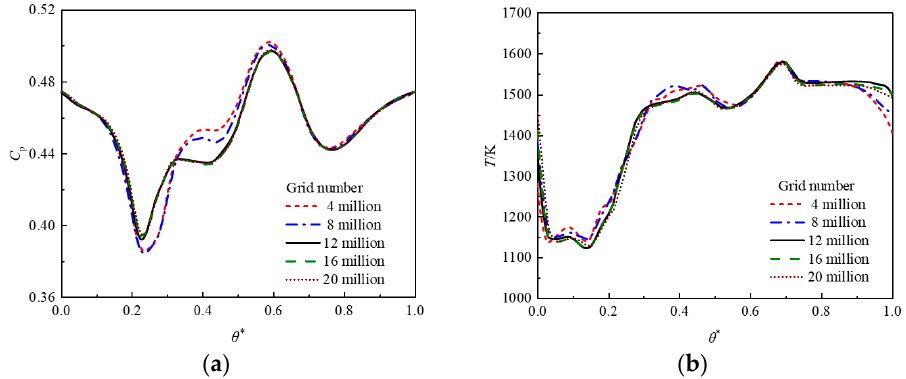
Figure 5. Grid independence test results: ( a ) the circumferential static pressure distribution at the sealing exit; ( b ) the circumferential temperature distribution at the sealing exit.